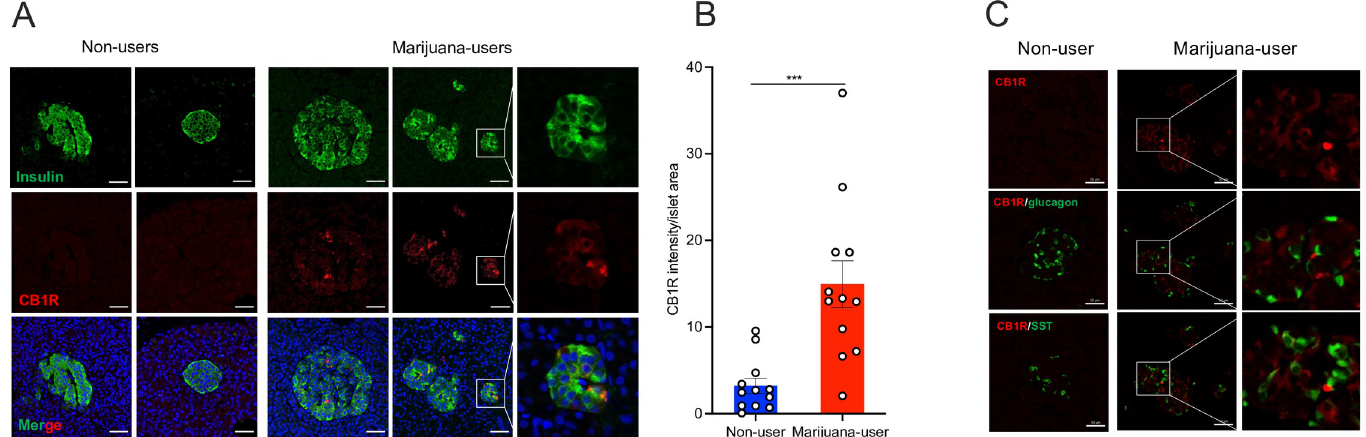
Fig 3. Islets from chronic marijuana-users display increased CB1R expression on islet beta cells. (A) Immunofluorescent staining of human pancreatic tissue from individuals with a history of non-use and chronic marijuana use. The sections were stained for CB1R (red) and insulin (green). Details of the staining are shown in the enlarged images. Two islet images are presented from non-users and marijuana-users. Confocal images were taken using Zeiss LSM 700. Scale bars, 50 μ m. (B) Quantitative analysis of CB1R expression. The CB1R intensity per islet area was compared between the two donor groups. Samples from five non-user donors and from six marijuana-user donors were counted for the analysis. ��� p < 0.001. The values were expressed as mean ± SEM. Each dot in the bar graph represents calculated value from an islet. (C) Immunofluorescent staining of human pancreatic tissue from individuals with a history of chronic marijuana use and non-use. The sections were stained for CB1R (red), glucagon (green), and somatostatin (green). Details of the staining are shown in the enlarged images. Images are presented from samples from four non-users and four marijuana-users. Confocal images were taken using a Zeiss LSM 700 microscope. Scale bars, 50 μ m.